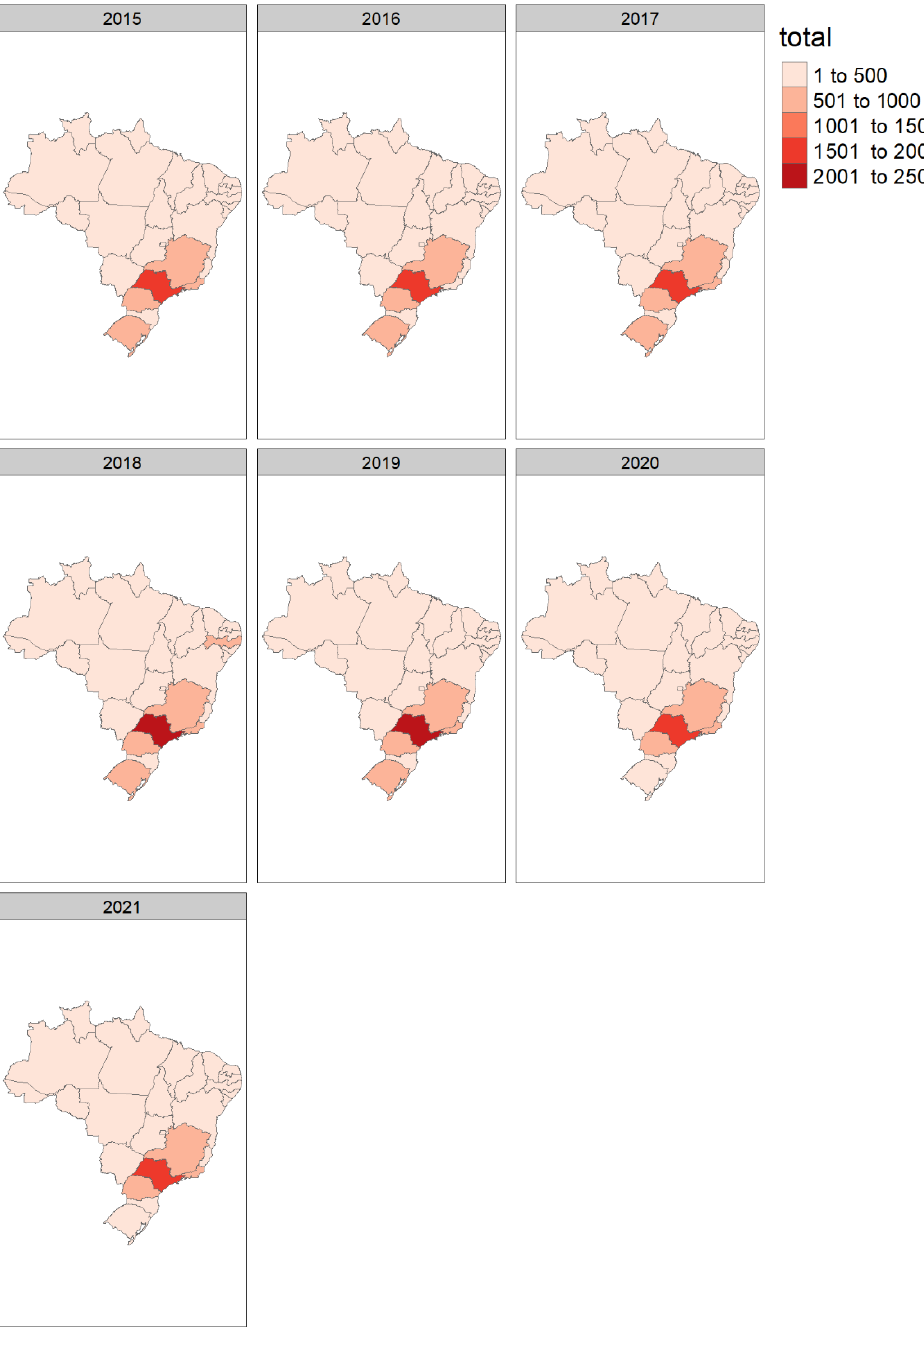
Figure 2. Total number of solid organ transplants performed in Brazil’s Unified Healthcare System (SUS) from 2015 to 2021 by state.